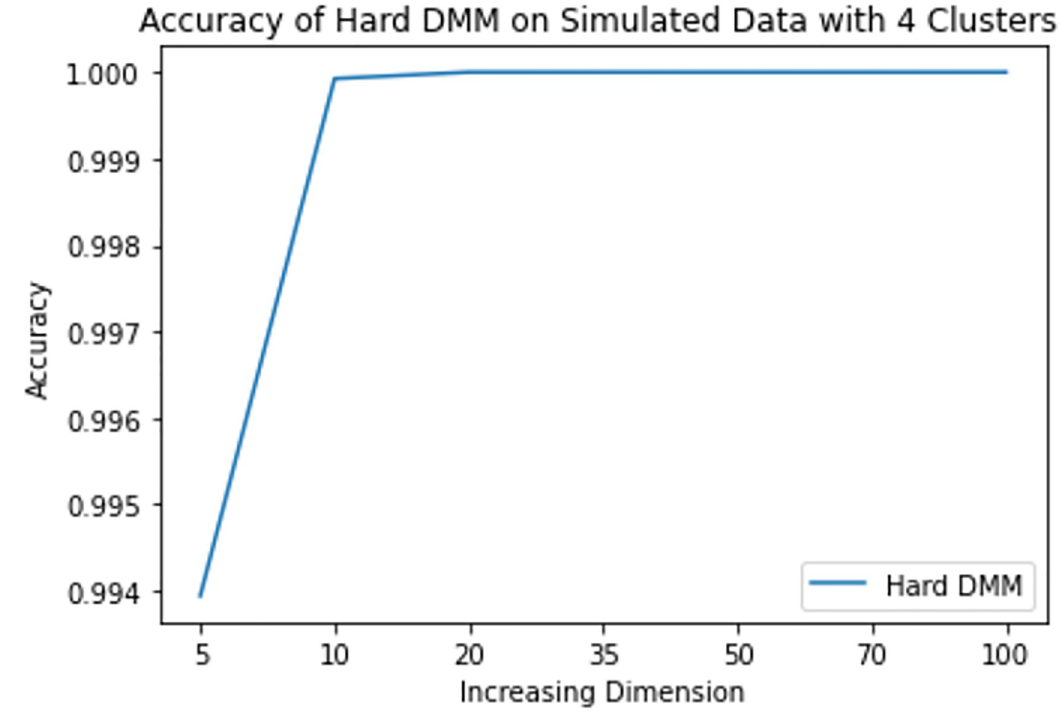
Fig 11. Mean accuracy of hard DMM 1 with 4 clusters and varied